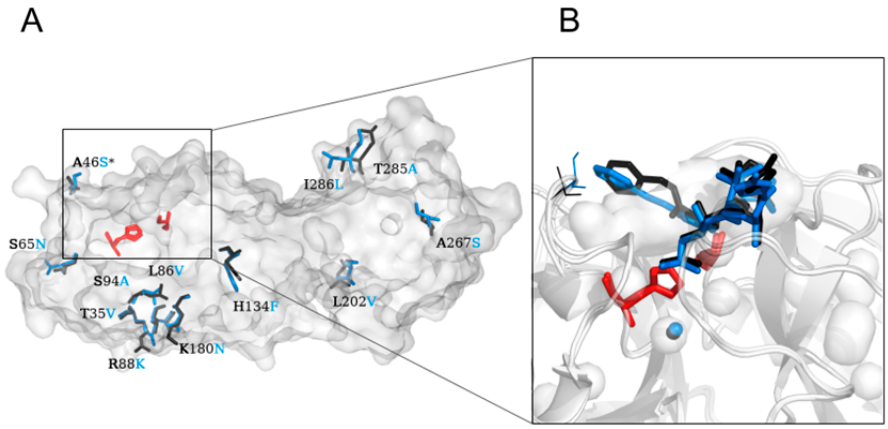
Figure 1. The differences between the severe acute respiratory syndrome coronavirus main protease (SARS-CoV Mpro) and SARS-CoV-2 Mpro structures. ( A ) The overall structure of both SARS-CoV and SARS-CoV-2 Mpros with differing amino acids are marked as black (SARS-CoV Mpro) and blue (SARS-CoV-2 Mpro). ( B ) Close-up of the active site cavity and bound N3 inhibitor into SARS-CoV (black sticks) and SARS-CoV-2 (blue sticks) Mpros. The catalytic water molecule that resembles the position of the third member of the catalytic triad adopted from the cysteine proteases is shown for both SARS-CoV (black sphere) and SARS-CoV-2 (blue sphere) Mpros. The active site residues are shown